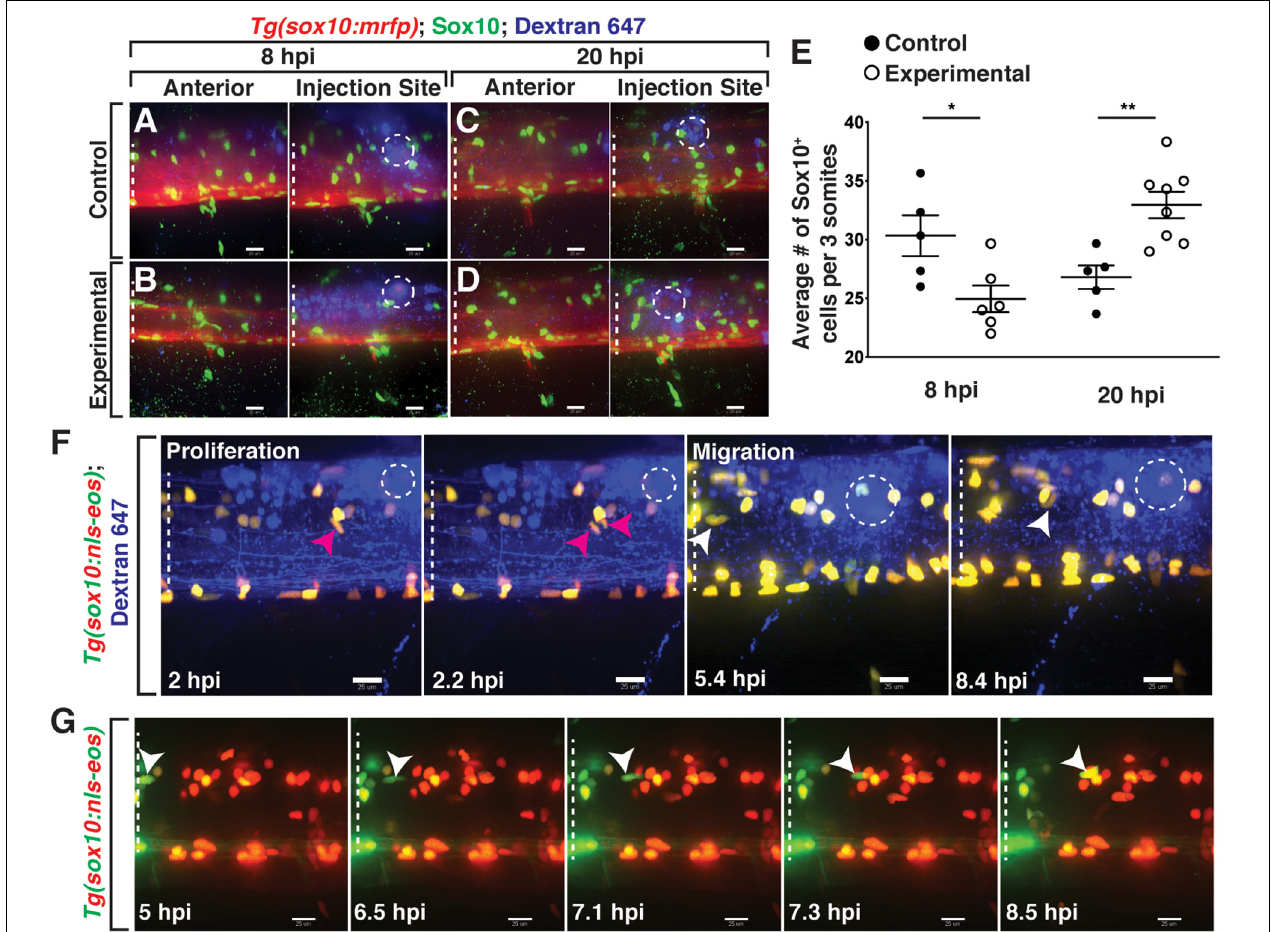
FIGURE 2 | Lysolecithin alters the number and behavior of Sox10 + cells in the spinal cord. All images are lateral views of the spinal cord with anterior to the left and dorsal to the top. (A–D) 4 dpf Tg ( sox10:mrfp ) zebrafish larvae injected with either a control solution [control, (A,C) ] or lysolecithin [experimental, (B,D) ] containing the fluorescent tracer Dextran-647 to identify the injection site. Injected zebrafish were fixed at 8 hpi (A,B) or 20 hpi (C,D) and labeled with an antibody to Sox10 (green). (E) Quantification of the average number of Sox10 + cells within the injection site and spanning the width of approximately three motor nerves to capture the effects from lysolecithin (experimental) or control solutions. * p = 0.0252 at 8 hpi ( n = 5 control; n = 6 experimental) and ** p = 0.0033 at 20 hpi ( n = 5 control; n = 8 experimental). Statistical significance was measured using an unpaired t -test. (F) Time-lapse imaging of proliferation (red arrowhead) and migration (white arrowhead) of sox10 + cells in a Tg ( sox10:nls-eos ) zebrafish larva following injection of lysolecithin at 4 dpf. White dashed ellipse denotes the injection site. (G) Time-lapse movie following injection of lysolecithin and photoconversion of the lesion area in a 4 dpf Tg ( sox10:nls-eos ) zebrafish larva. Red fluorescence denotes the photoconverted cells within the lesion. Green fluorescence denotes the cells outside of the lesion. Arrowhead identifies a sox10 + cell anterior to the injection site that migrates posteriorly into the drug dispersal region. White dashed lines denote the spinal cord. Scale bars, 25 µ